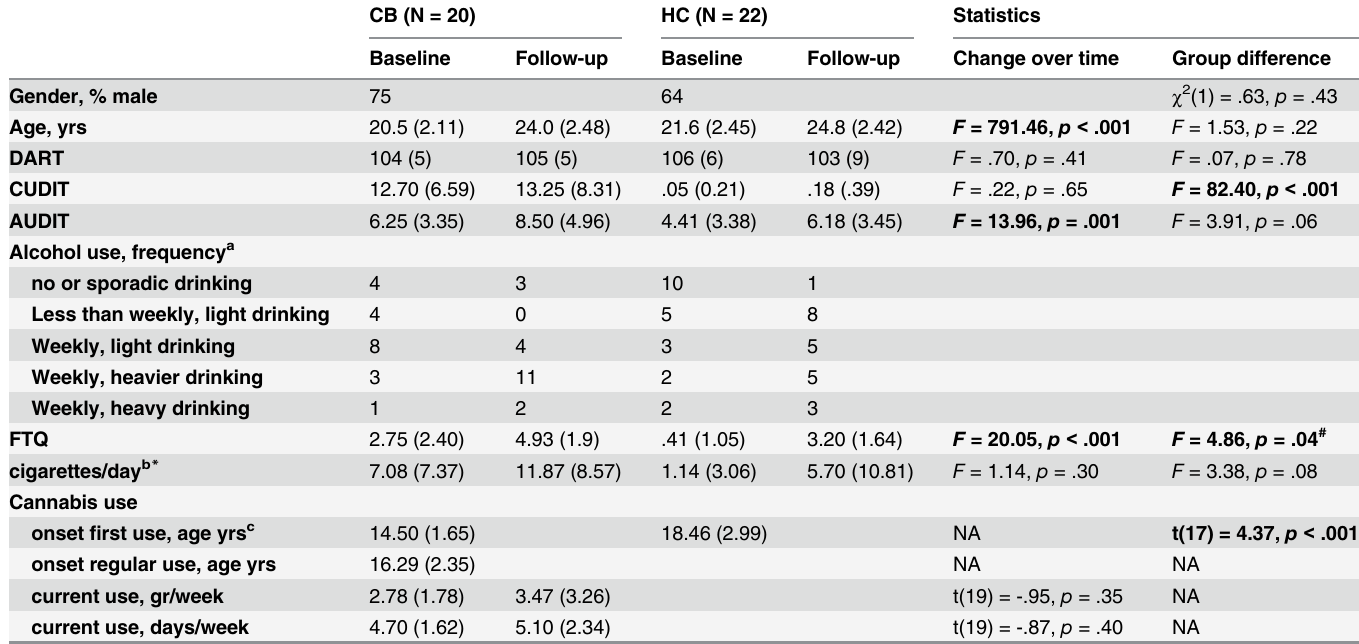
Table 1. Demographic information in mean and standard deviations, per group (heavy cannabis users, CB and healthy controls, HC) per time point (baseline and follow-up).